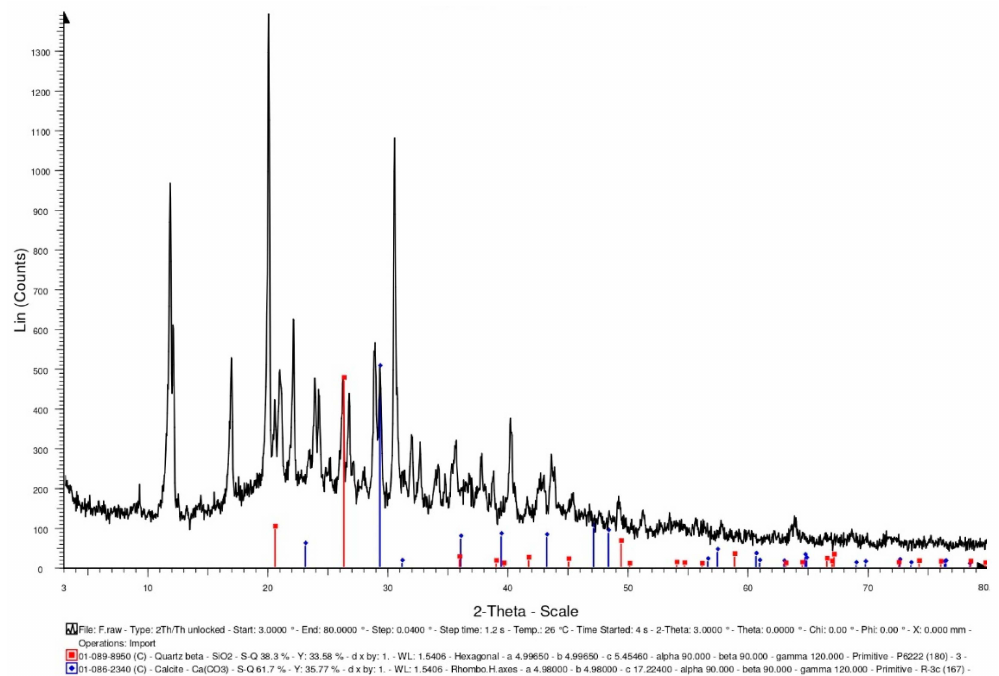
Figure 9. XRD-analysis results of the bacteria powders subjected to high temperature.